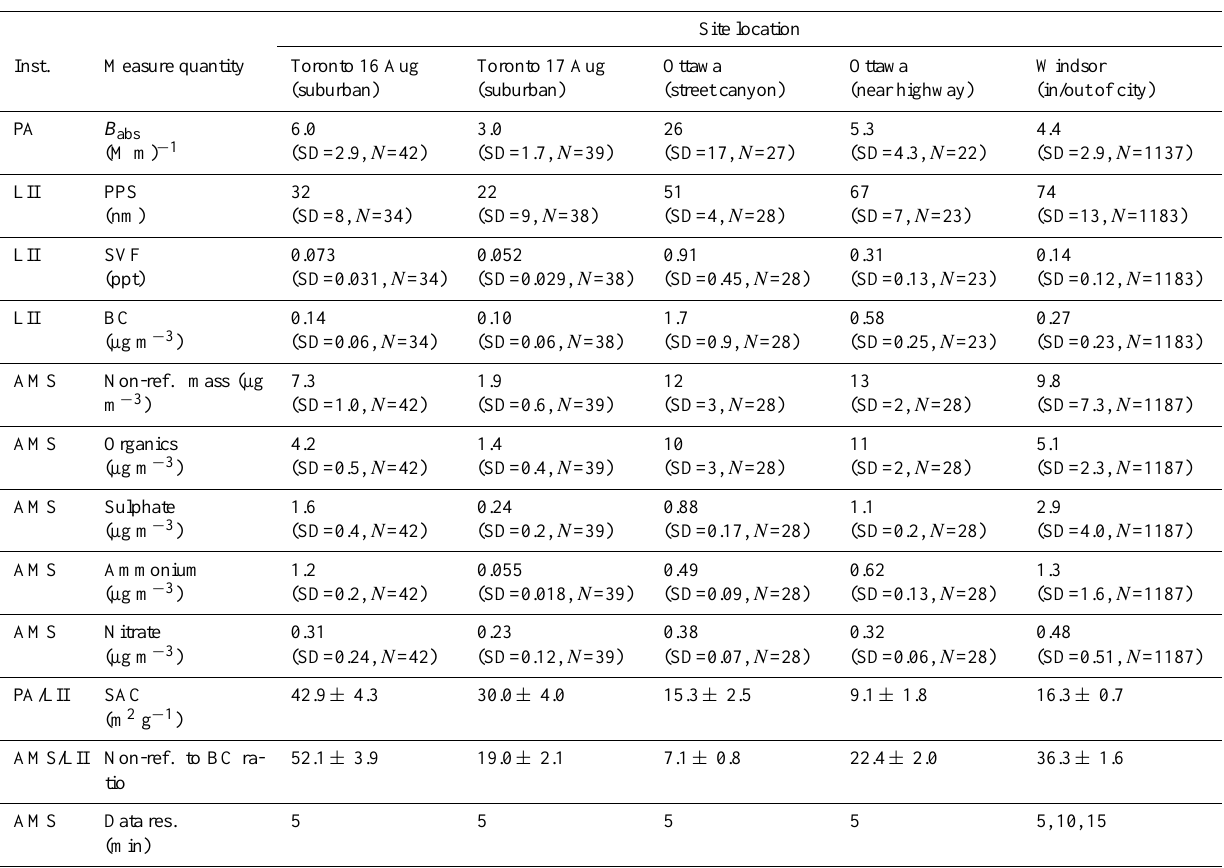
Table 1. Average values for various measure quantities presented in this work. Standard deviations and the number of valid data points are included in brackets. The particle light absorption coefficient ( B abs ) is measured from the photoacoustic spectrometer (PA). The primary particle size (PPS) and soot volume fraction (SVF) are obtained with the laser-induced incandescence instrument (LII). The black carbon mass concentration is calculated based on the SVF. The non-refractory mass and the breakdown of the average mass concentrations of the four major particle components are based on measurements from the Aerosol Mass Spectrometer (AMS). Specific absorption cross-section (SAC) for the period/location of interest is calculated based on the ratio of the averages of the B abs and SVF measurements. Corresponding uncertainties are propagated from errors from B abs and SVF measurements. The non-refractory mass to BC mass is the ratio between the average value of non-refractory mass and the BC mass. The data resolution indicates the time resolution of the AMS data which the PA and LII measurements have been averaged to match accordingly. The Toronto data presented here are from the measurements obtained when the denuder was